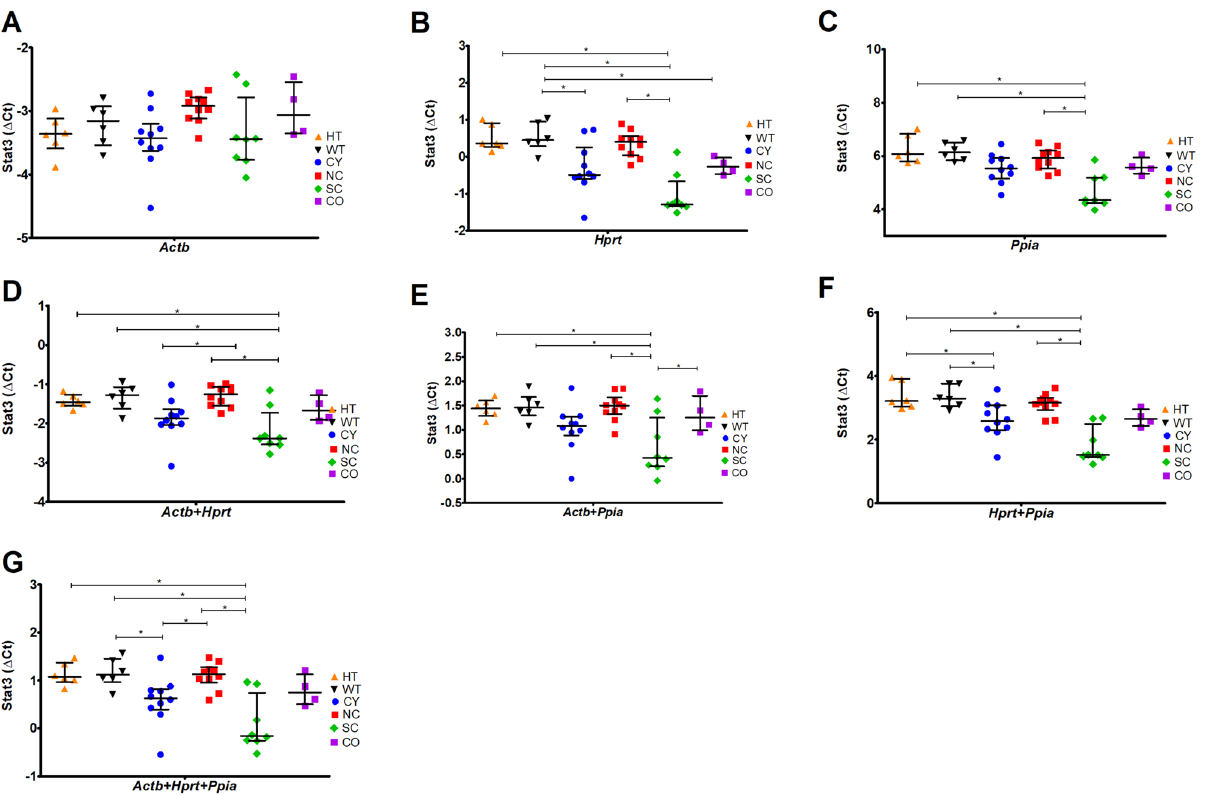
Figure 6. The ΔCt values of Stat3 expression target gene normalized by different combinations of the three best candidate housekeeping genes ( Actb , Hprt and Ppia ) ( A ) Stat3/Actb , target expression normalized by Actb ; ( B ) Stat3/Hprt , target expression normalized by Hprt ; ( C ) Stat3/Ppia , target expression normalized by Ppia ; ( D ) Stat3/Actb + Hprt , target expression normalized by Actb + Hprt ; ( E ) Stat3/Actb + Ppia , target expression normalized by Actb + Ppia ; ( F ) Stat3/Hprt + Ppia , target expression normalized by Hprt + Ppia , ( G ) Stat3/Actb + Hprt + Ppia target expression normalized by Actb + Hprt + Ppia . The median values are represented as horizontal lines and the error bars represent interquartile ranges. CY, cystic; NC, noncystic; HT, haploinsufficient; WT, wild type; SC, severely cystic phenotype; CO, control for the severely cystic phenotype. *p < 0.05 by Kruskal–Wallis with Dunn’s post-hoc test, followed by FDR